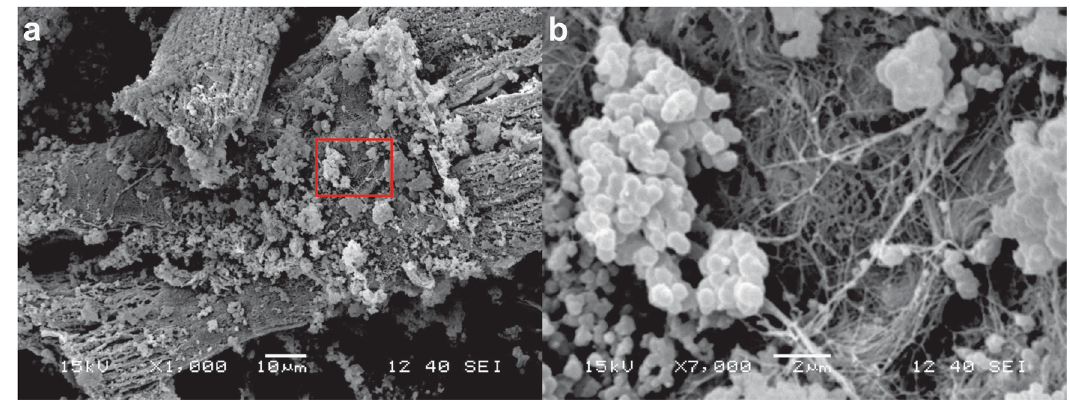
Fig. 8 a ARVC with fi bers on its surface. b ARVC surface